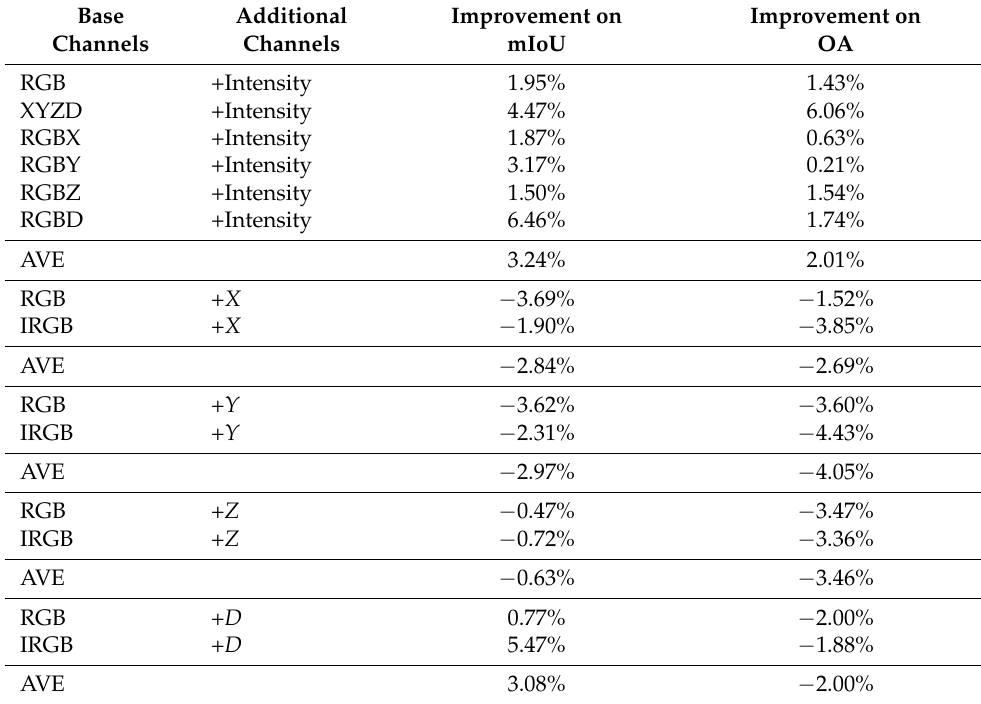
Table 3. Average improvement by adding different channels.